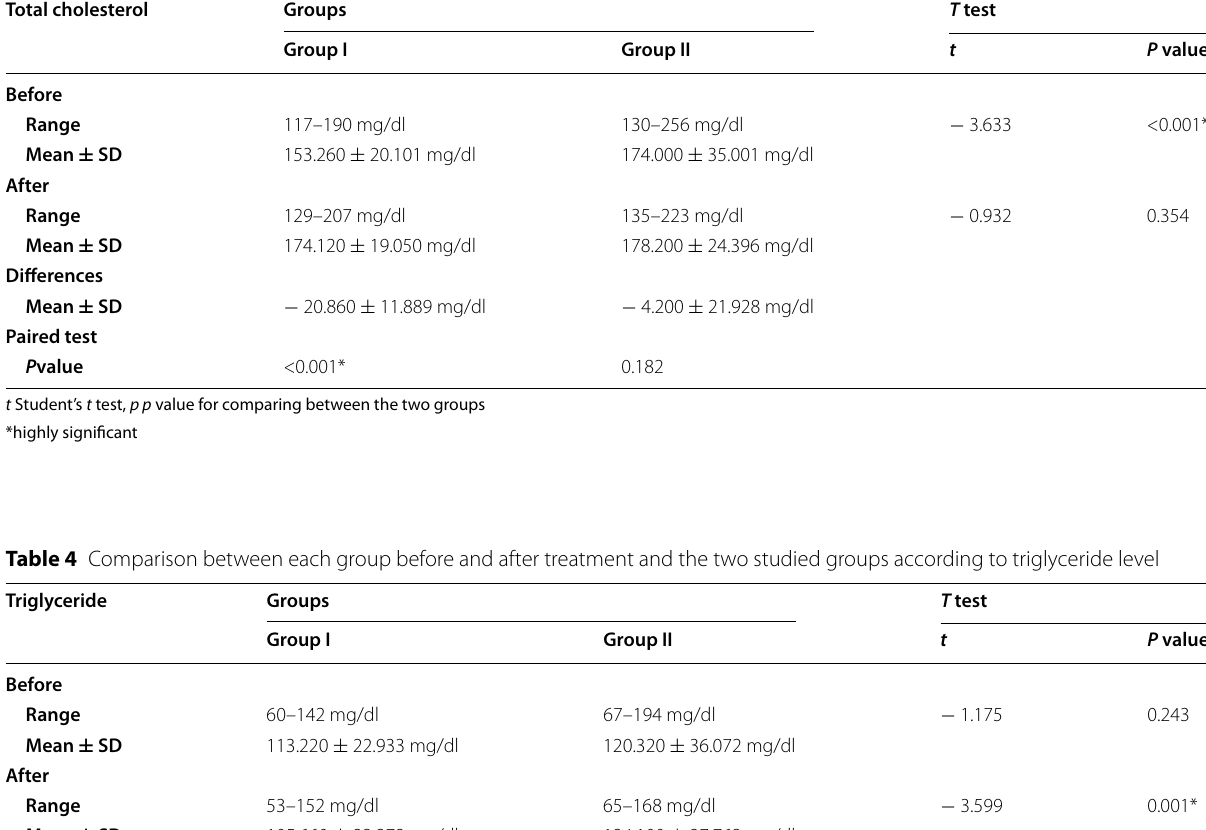
t Student’s t test, p p value for comparing between the two